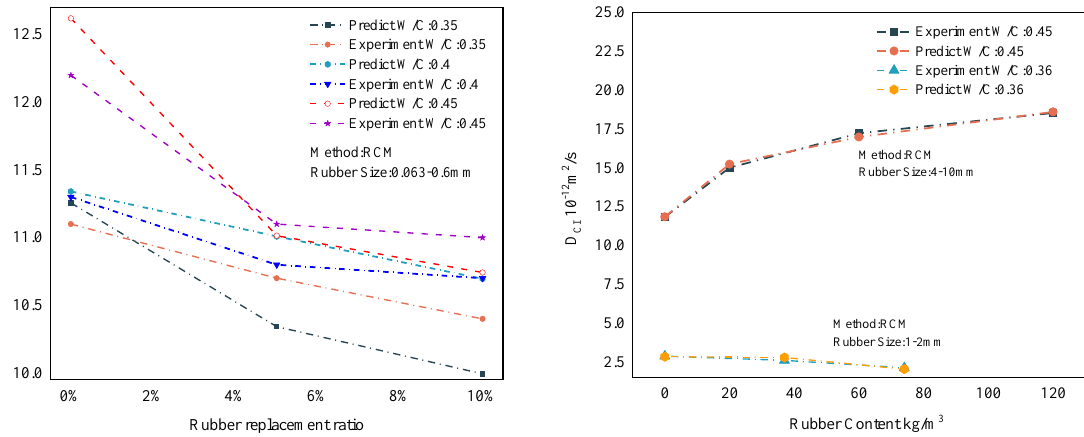
Figure 18. Prediction results of the MWOA-ELM model for the literature [57] ( Left ), [59] ( Right , Up ), and [58] ( Right , down ).